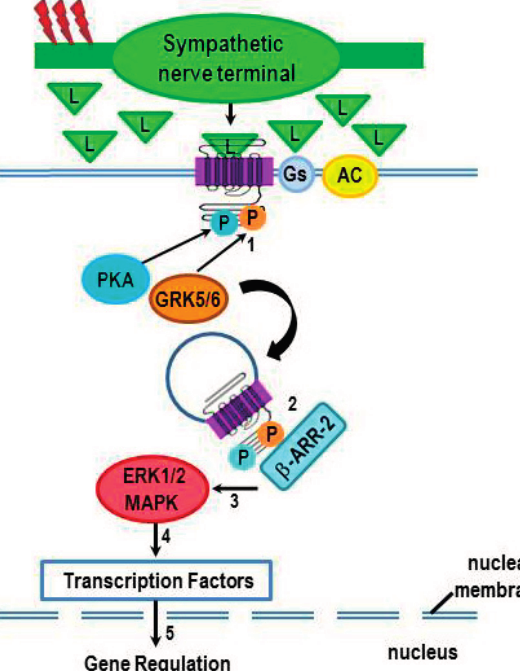
Figure 5. Phosphorylation of β 2 -AR by GRK-2, -5, and -6 occurs in an agonist concentration-dependent manner to induce different receptor functions. High sympathetic firing activity (red lightning bolts) drives the β 2 -AR-Gs-independent (non-canonical) pathway by flooding the extracellular space with ligand (L, i.e. NE). Chronic receptor activation induces not only PKA-mediated phosphorylation of the receptor, but also phosphorylation by GRK5/6 (#1) instead of GRK2. Receptor phosphorylation by PKA and GRK5/6 promote receptor desensitization and internalization by recruiting β -arrestin 2 ( β -ARR-2) to the receptor (#2). Once bound to the receptor, β -arrestin-2 acts as a scaffold for the sustained activation of the MAPK, ERK 1/2 (#3). Beta-arrestin activation of ERK1/2 MAPK, in turn, increases the translocation of transcription factors (#4) into the nucleus to influence gene transcription